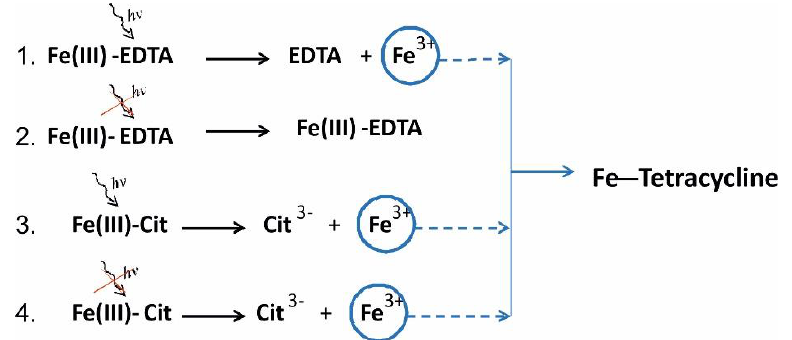
Figure 11. Proposed scheme of TC degradation under different lighting conditions. The degradation rate constants (k) of TC with Fe(III)-EDTA and Fe(III)-Cit, respectively, at 20 °C are following: 1) k = 1012 M −1 day − 1 , 2) k = 55.4 M − 1 day −1 , 3) k = 15,440 M − 1 day − 1 , 4) k = 4240 M − 1 day − 1 .